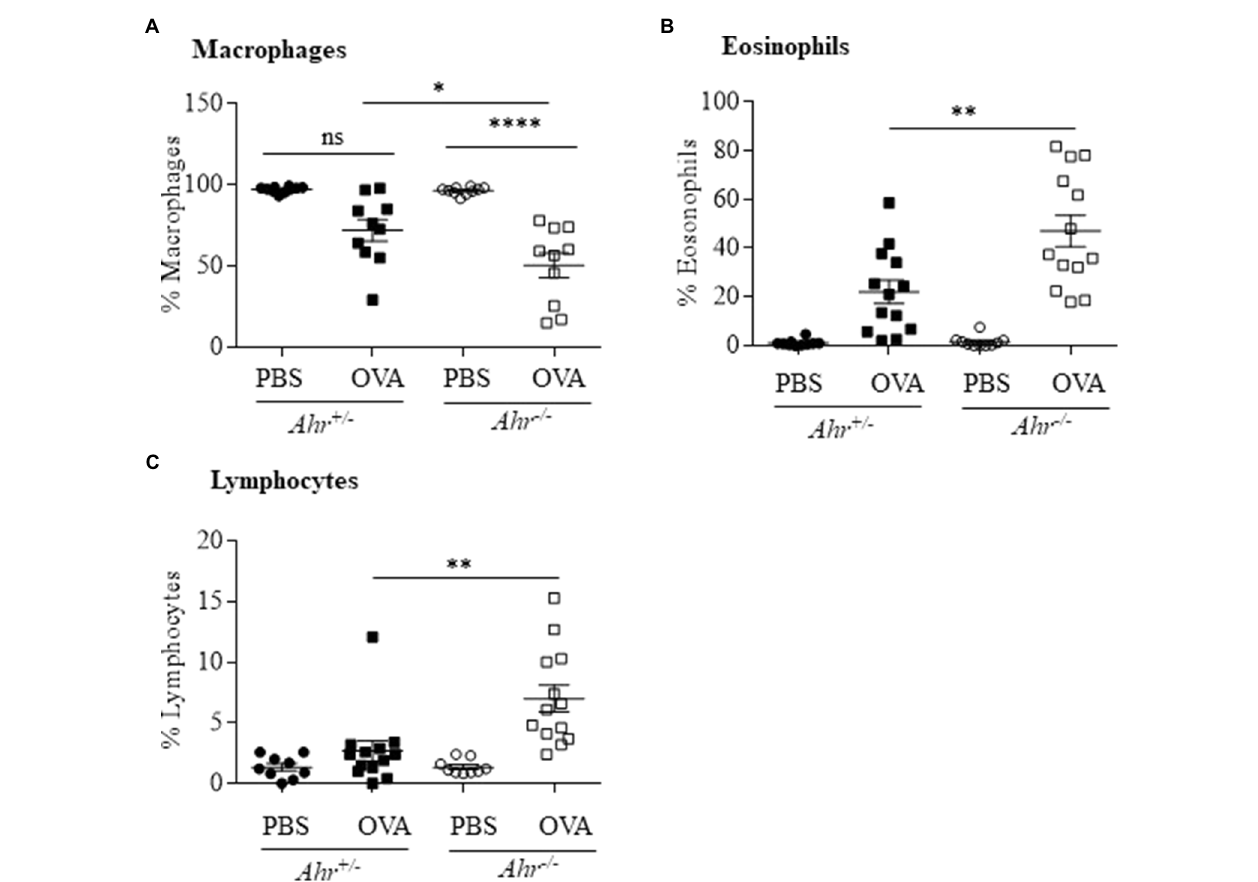
FIGURE 2 | Percentage of immune cells in OVA-induced airway inflammation. (A) Macrophages – there was a significant difference in the percentage of macrophages between OVA-challenged Ahr − / − and Ahr+/ − mice (* p = 0.0232; **** p = 0.0001 between PBS and OVA-challenged Ahr − / − mice). (B) Eosinophils – there was a significantly higher percentage of eosinophils in OVA-exposed Ahr − / − mice compared with OVA-exposed Ahr+/ − mice (** p = 0.0011). (C) Lymphocytes – there was a significantly higher percentage of lymphocytes in OVA-exposed Ahr − / − mice compared with OVA-exposed Ahr+/ − mice (** p = 0.0016). Results are expressed as the mean ± SEM from two independent